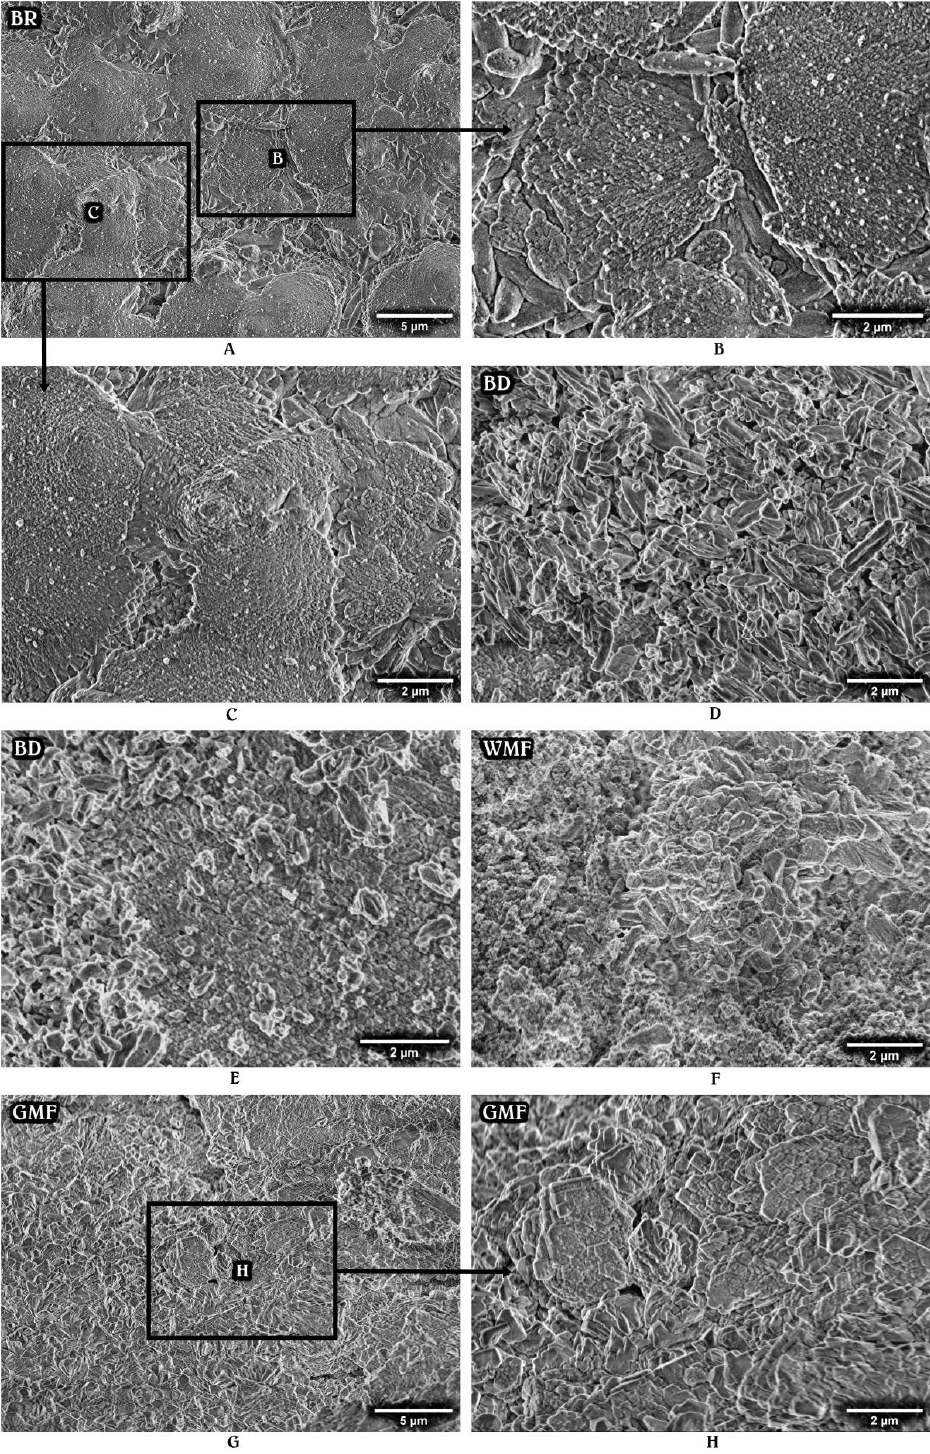
Figure 3. Representative SEM images (×4.0k and ×10.0k magnification) of mixed hydraulic calcium silicate-based materials: BR ( A – C ), BD ( D , E ), WMF ( F ), and GMF ( G , H ) after the storage in HBSS for 28 days.